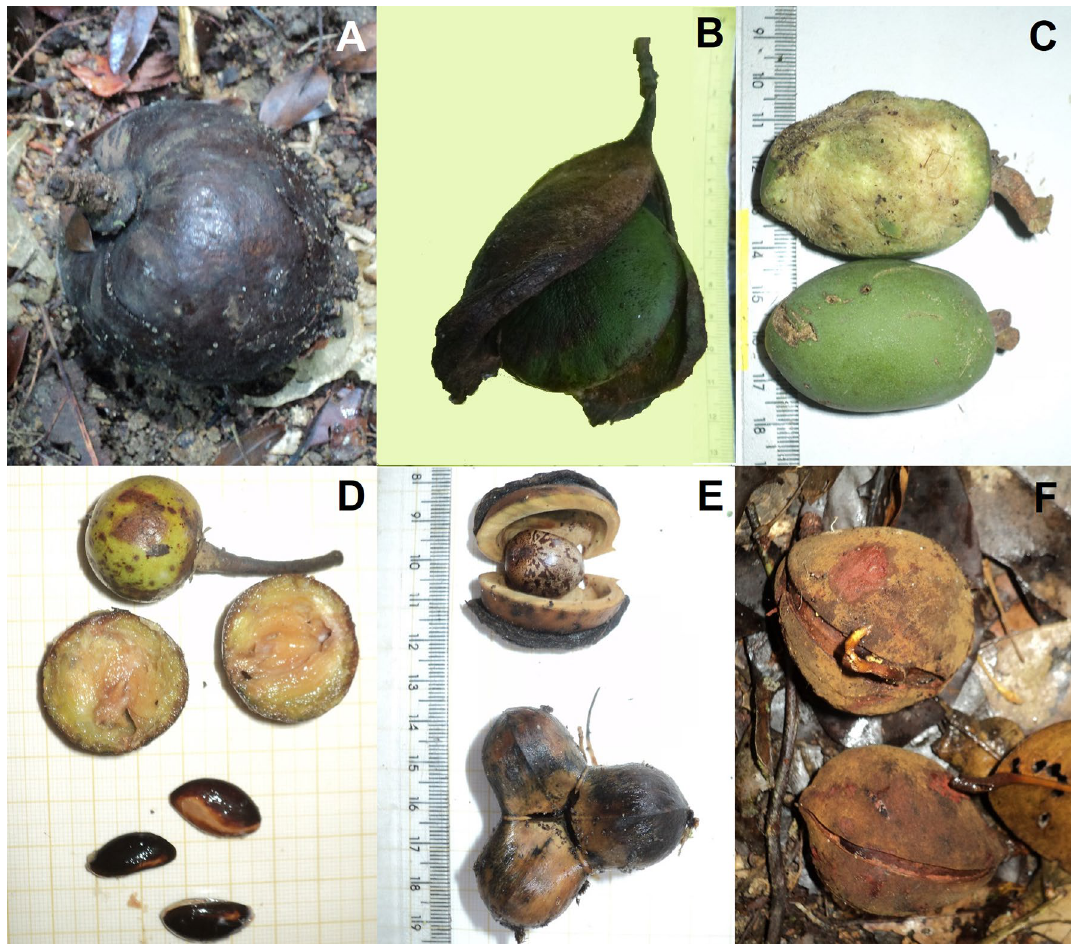
Figure 5. Examples of fruit-fall survey inclusion criteria. Not collected and not counted: ( A ) Fusaea longifolia (Annonaceae) rotten fruit: ( B ) Vatairea guianensis (Fabaceae) dried fruit. Counted: ( C ) Dipteryx odorata (Fabaceae) partially eaten and fresh counted not collected (partially eaten fruit was just counted); ( D ) Manilkara huberi (Sapotaceae) collected and counted, fresh fruits and seed collected to weigh; ( E ) Hevea brasiliensis (Euphorbiaceae) counted and removed to avoid repetitive sampling; ( F ) Vouacapoua americana (Fabaceae) counted and removed. Germinating fruits not collected for weighing and also not counted in a second